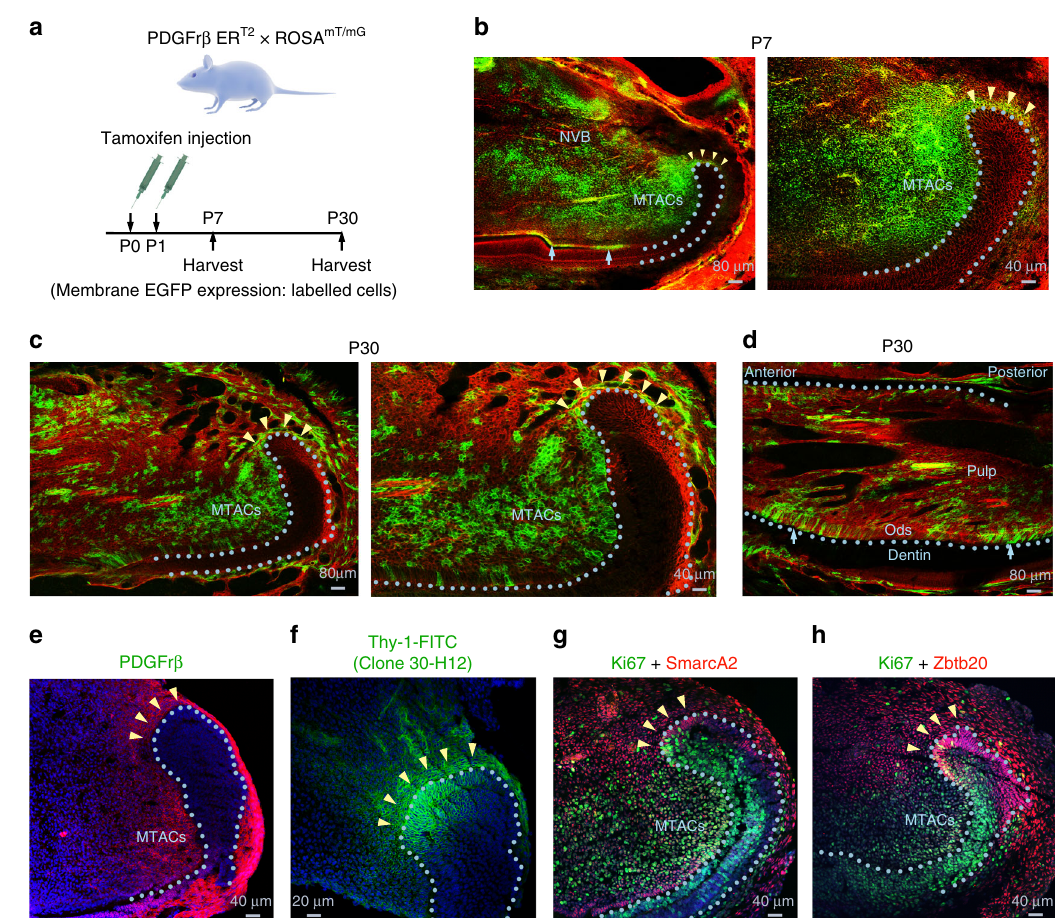
Fig. 3 Lineage tracing MSCs in the incisor tooth. a Strategies of PDGFr β Cre ER T2 and ROSA mT/mG mouse crossing and tamoxifen injection and sample harvesting are displayed. Illustration taken from https://www.somersault1824.com/science-illustrations/, which provides png images free to use and alter under the creative commons 4.0 license. b Representative mT/mG signal analysis at P7. Arrows mark clusters of odontoblasts that are EGFP positive. MTACs mesenchymal transit amplifying cells, NVB neurovascular bundle region. c , d Representative mT/mG signal analysis at